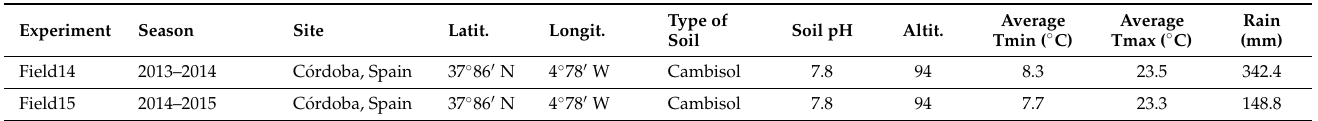
Table 1. Description of the sites for field testing. Climatic data correspond to the field seasons only (1 December to 30 June). Latit.